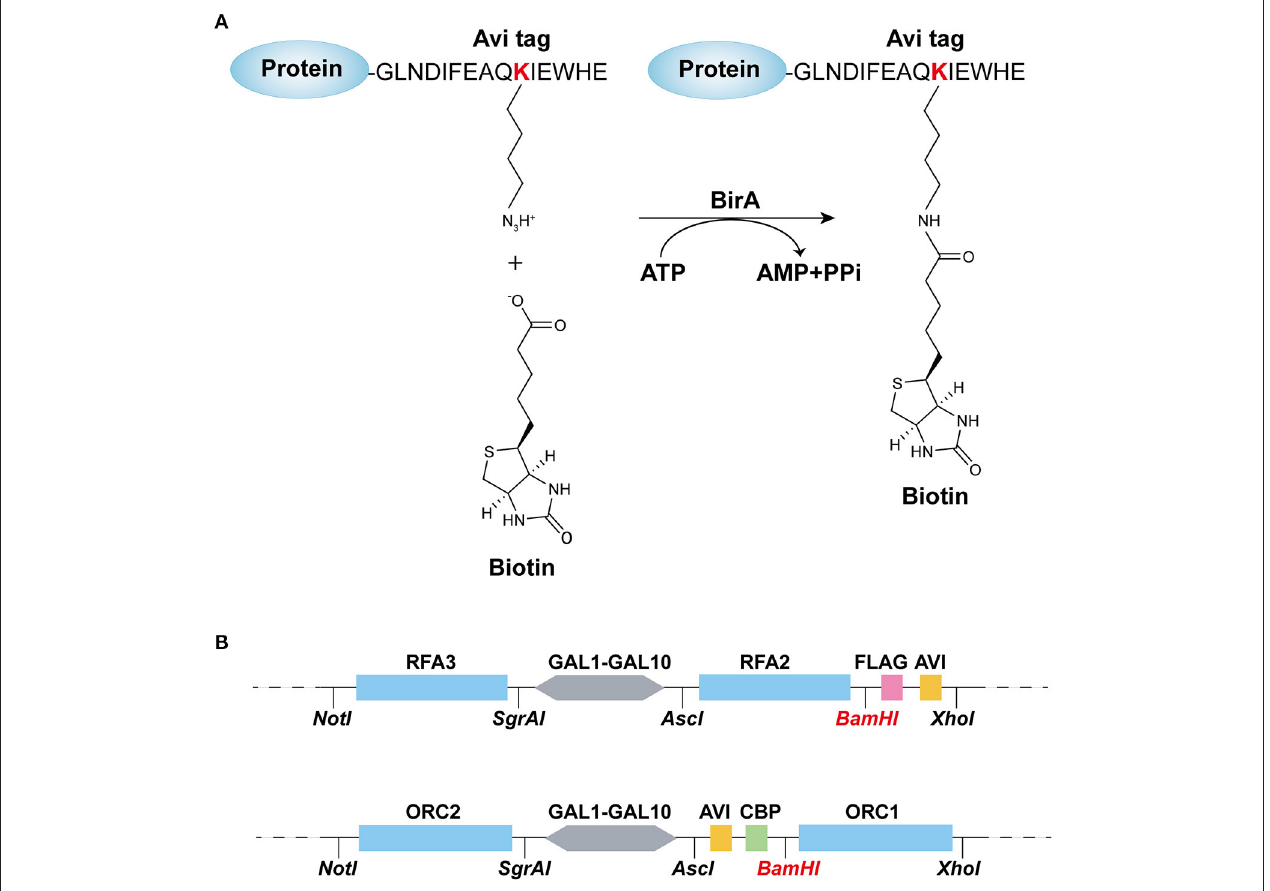
FIGURE 1 | Recombination-protein biotinylated system established in budding yeast. (A) Avi-tagged target protein biotinylated by BirA. (B) Main elements and enzyme sites of (top) pC-AVI and (bottom) pN-AVI. The two plasmid maps are given in Figures S1, S2.